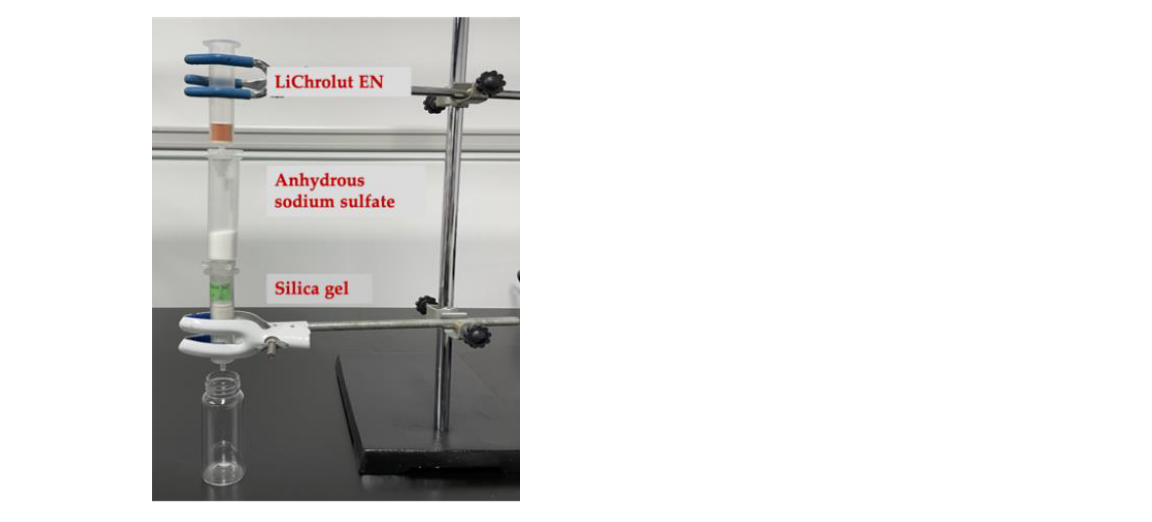
Figure 2. Tandem Lichrolut EN and silica gel SPE columns for simultaneous extraction and frac-